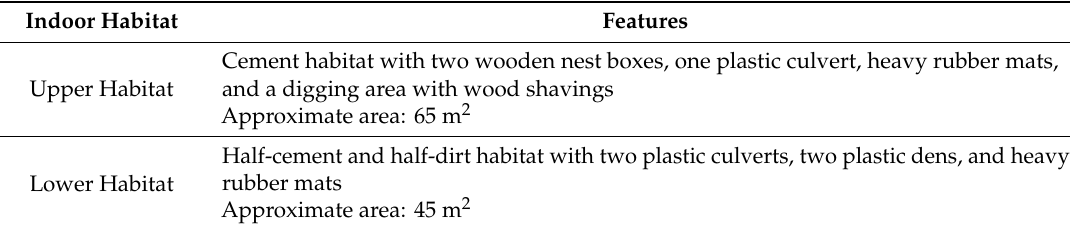
Table 1. Description of indoor habitats.